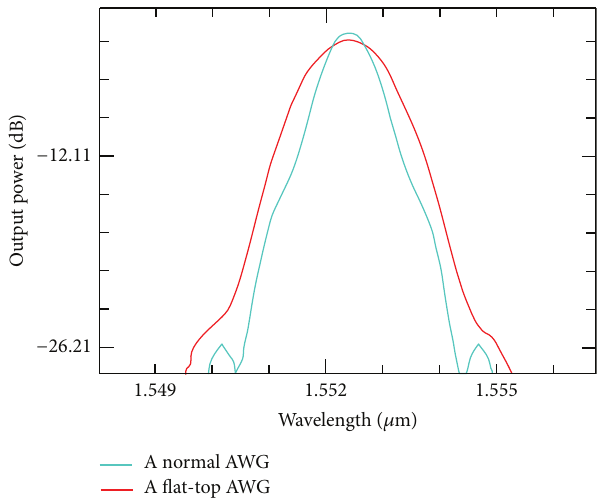
Figure 12: Comparison of single-channel output spectra of flattened and unflattened AWGs.